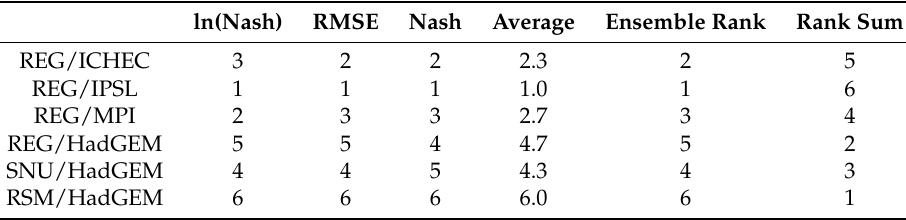
Table 3. Ranks of climate models.